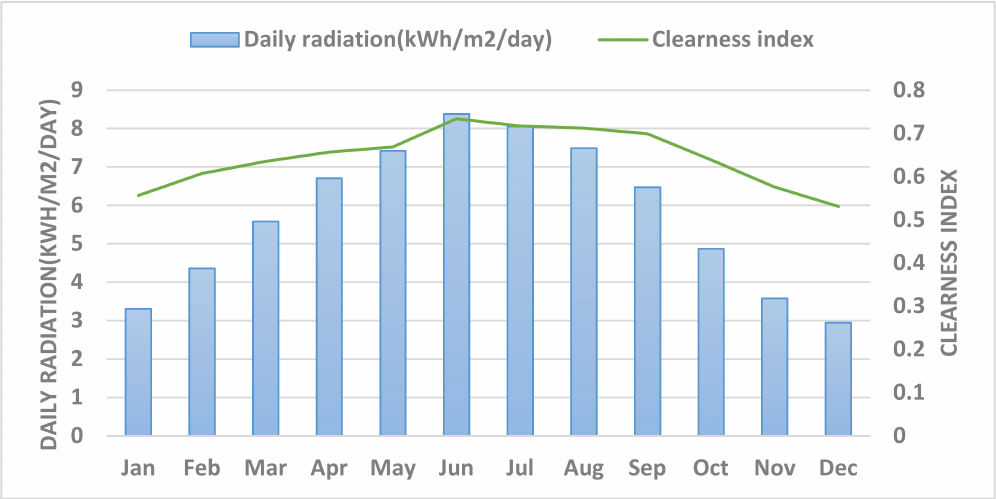
Figure 6. The annual average global irradiance of the selected case study.